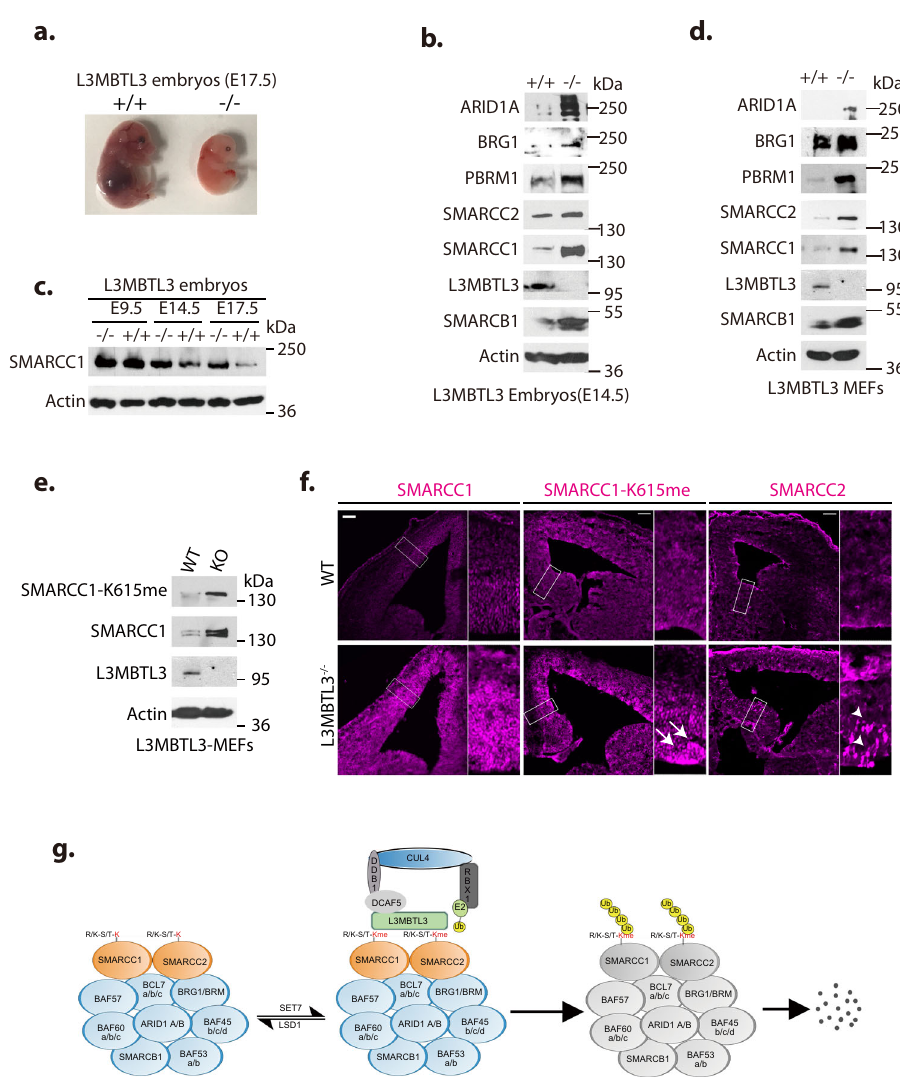
Fig. 8 | L3MBTL3 regulates the proteolysis of SMARCC1 and SMARCC2 during mouse development. a The mouse L3MBTL3 wildtype (+/+)and L3MBTL3 null ( − / − , KO)mutantembryos on embryonic day17.5 (E17.5)after breeding.The genotypesweredeterminedfromgenomicDNAisolatedfromthewildtypeand the L3MBTL3 nullembryos.Repeated three times with thesame results. b Total lysatesfromtheheadsofmouse L3mbt3 (+/+)anddeletion( − / − )mutantembryos (equaltotalproteins)wereanalyzedbyWesternblottingwithantibodiesforthe indicatedmSWI/SNFproteins. c Lysatesfromtheheadsofwildtypeand L3mbtl3 deletionembryoswere collected atvarious embryonic dates(E9.5, E14.5, and E17.5)and analyzed forSMARCC1 and actin proteinlevels. d Mouseembryonic fi broblastsfromthewildtypeand L3mbtl3 deletionmutantembryos(E13.5)were examined and representation of three independentexperiments is shownfor indicatedSWI/SNFproteinsbyWesternblotting. e The L3mbt3 (+/+)anddeletion ( − / − )mutantMEFs wereanalyzed formonomethylated K615of SMARCC1, total